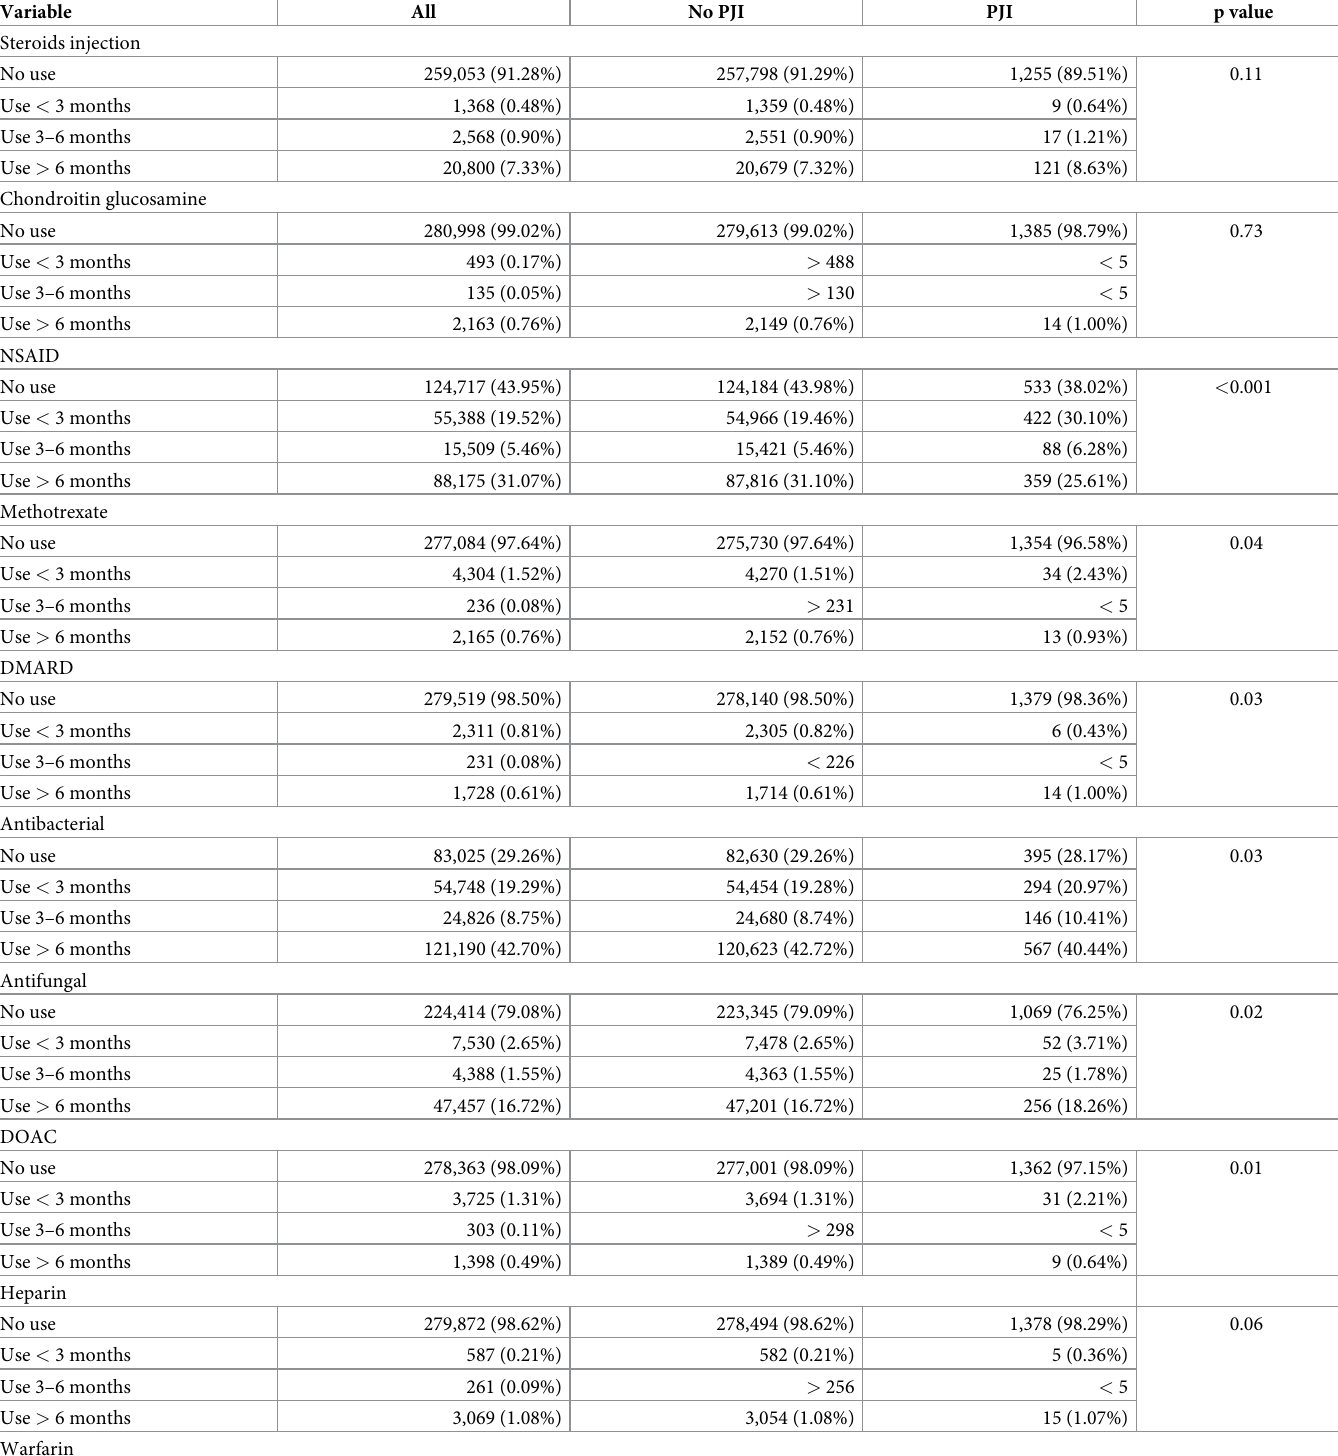
Table 4. Treatment history of patients at the time of hip or knee implant